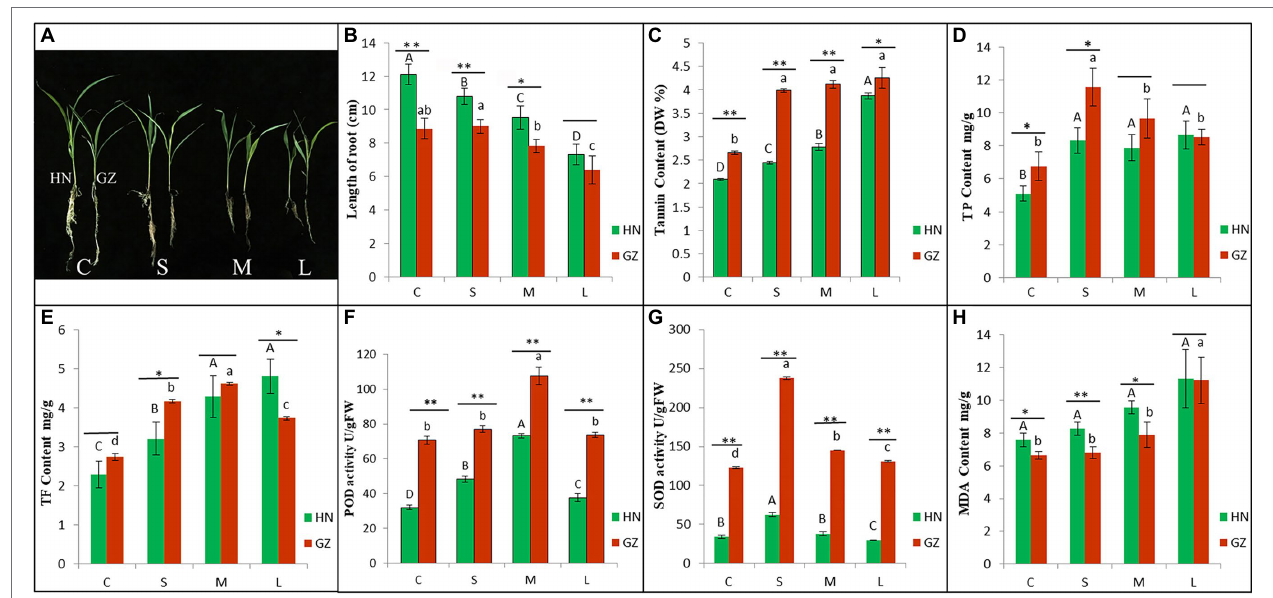
FIGURE 1 | The differences of phenotypic and physiological between HN and GZ under salt treatments. (A) Phenotypes of Sorghum “GZ” and “HN” under salt stress. (B) Length of root. (C) Tannin content. (D) The total phenol (TP) content. (E) The total flavonoid (TF) content. (F) POD activity. (G) SOD activity. (H) MDA content. Error bars represent standard errors of three biological replicates. The statistical significance between varieties was determined by the Student’s t test (** p < 0.01,* p < 0.05). The statistical significance between treatments was evaluated by one-way analysis of variance (ANOVA) with Duncan’s multiple comparison test ( p < 0.05). Capital letters indicate HN. Lowercase letters indicate